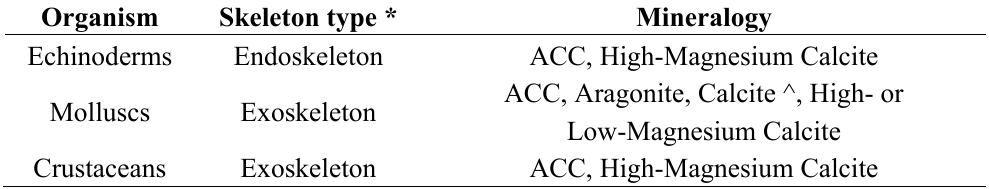
Table 1. Calcium carbonate polymorphs deposited by marine larvae